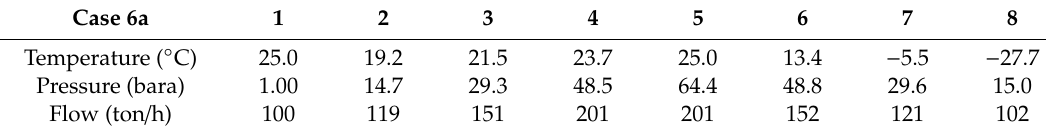
Table A12. Mass balance for Case 6a, stream numbering from Figure 3.